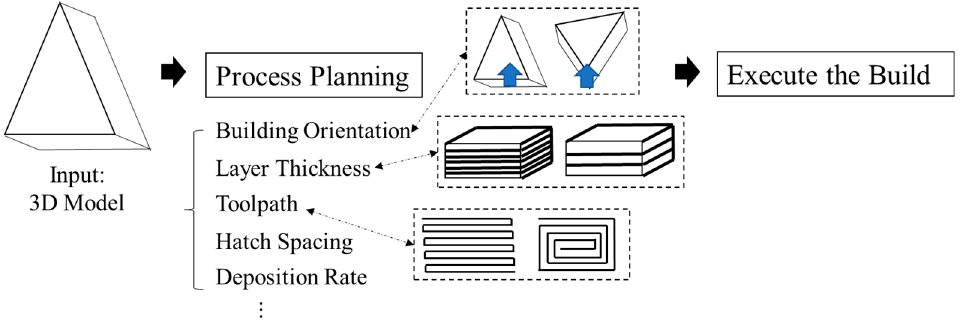
Figure 1. Workflow for AM builds preparation. Table 1. Optimization Strategies in FFF